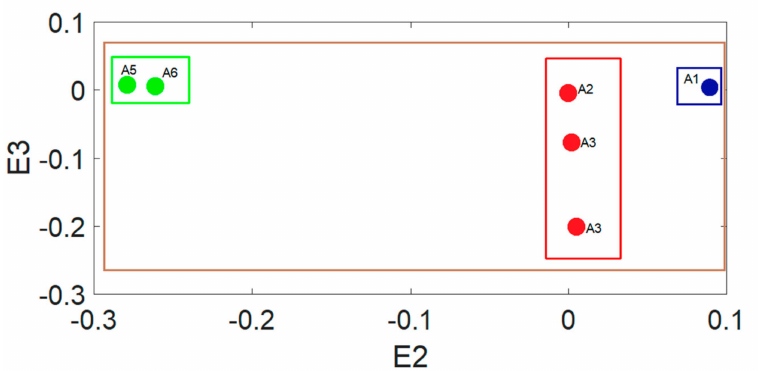
Figure 12. Area A classic domain and section